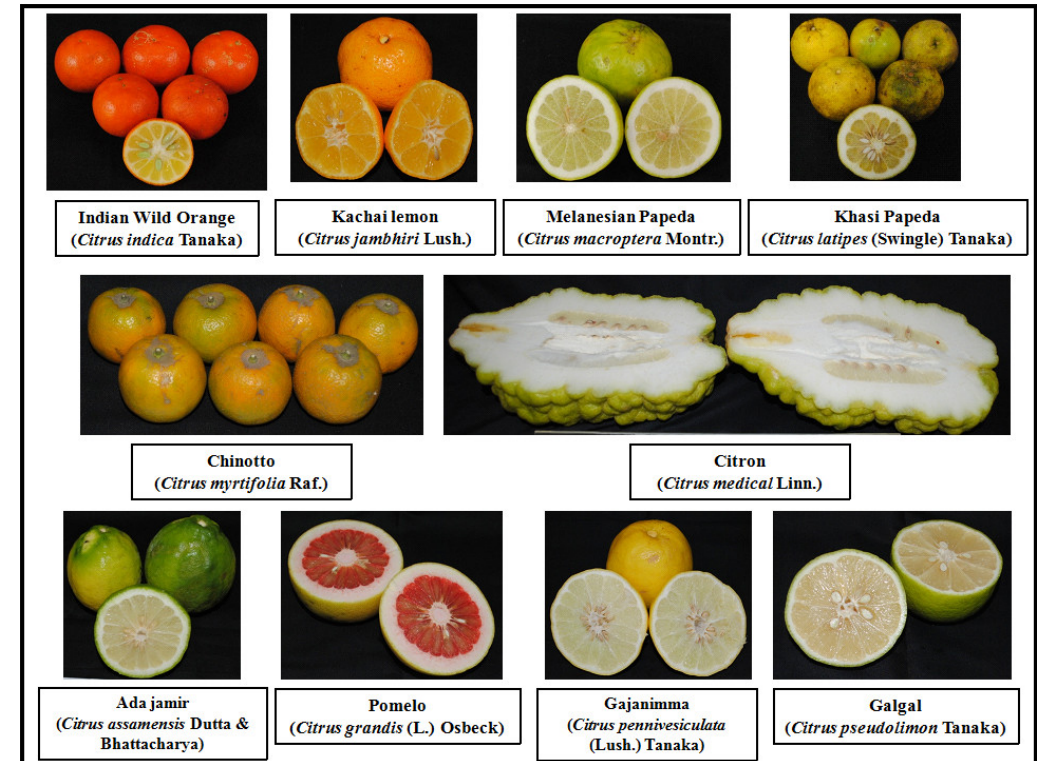
Figure 4. Underutilized citrus varieties collected from Nokrek Biosphere Reserve, West Garo Hills, Meghalaya, India. Table 2. Underutilized citrus varieties (common name, scientific name, and probable place of origin).